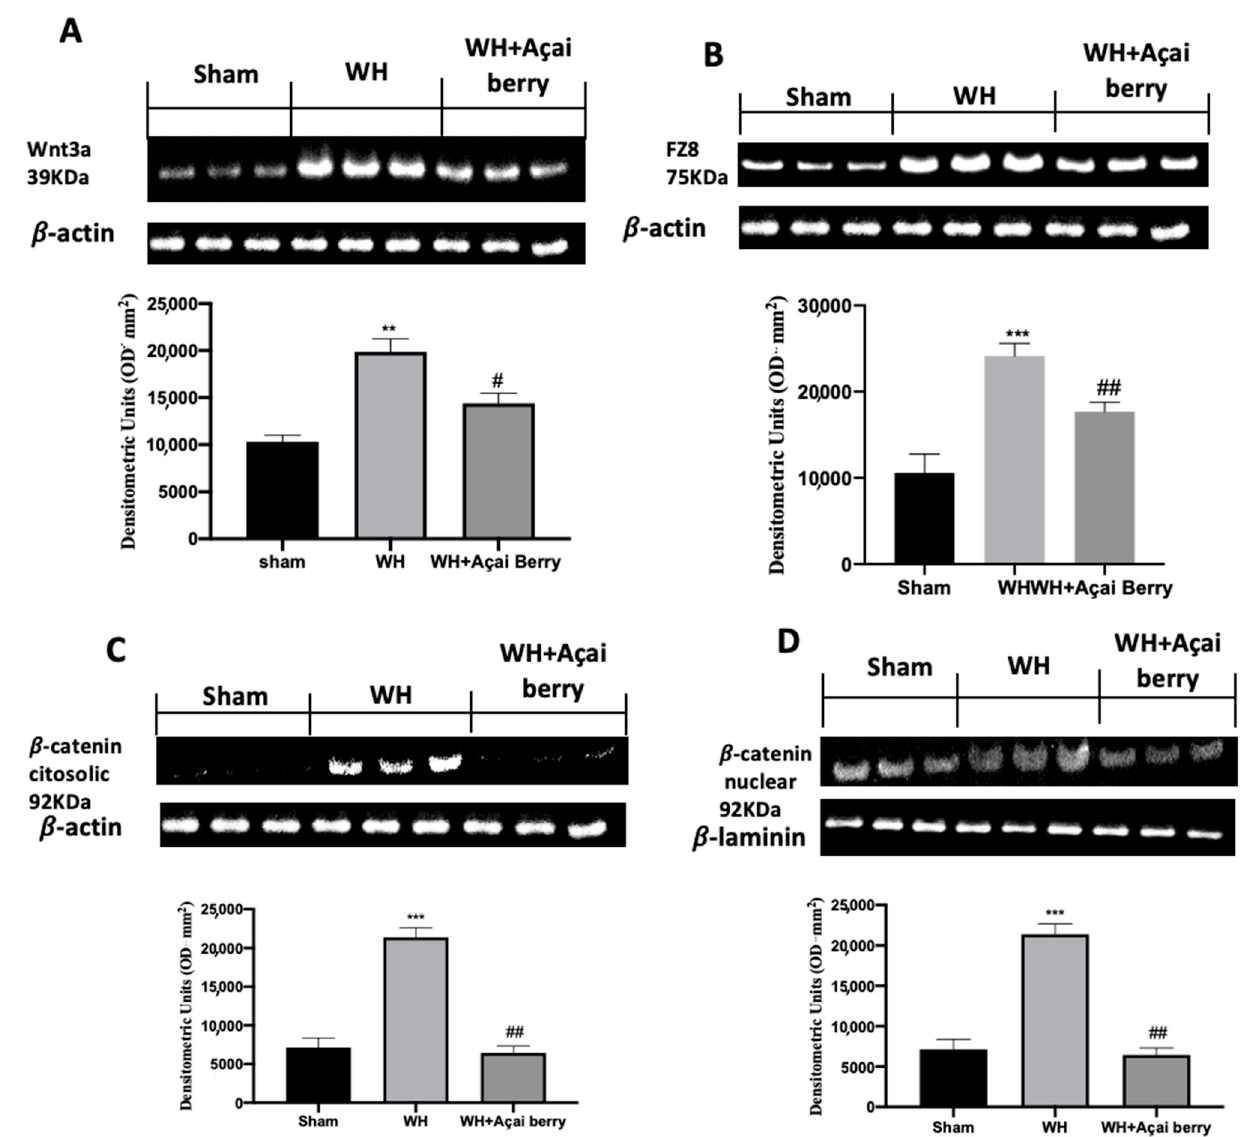
Figure 7. Western blot analysis of Wnt3a ( A ), FZ8 ( B ), cytosolic β -catenin ( C ), and nuclear β -catenin ( D ). A demonstrative blot of lysates with a densitometric analysis for all animals is shown. Data are expressed as the mean ± SEM of N = 6 mice/group. ** p < 0.01 vs. sham, *** p < 0.001 vs. sham; # p < 0.05 vs. WH; ## p < 0.01 vs. WH.